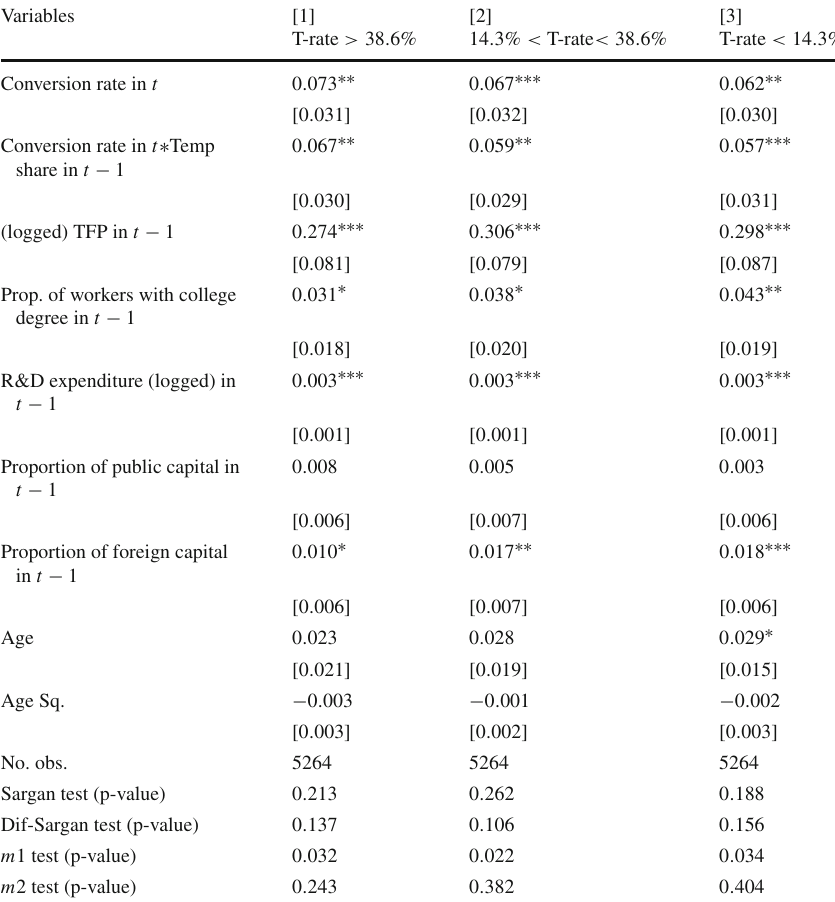
Table 8 Sys-GMM (cell) estimates of determinants of firms’ TFP (terciles of Temp-rates)